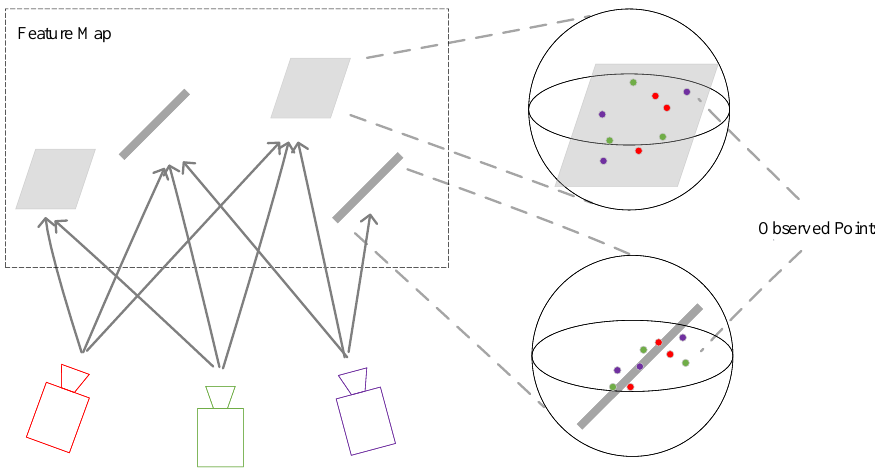
Figure 4. A map in 3D space. The two spheres on the right show the details of the planar and edge features. The different colored points in the spheres correspond to the LiDAR scans of the same